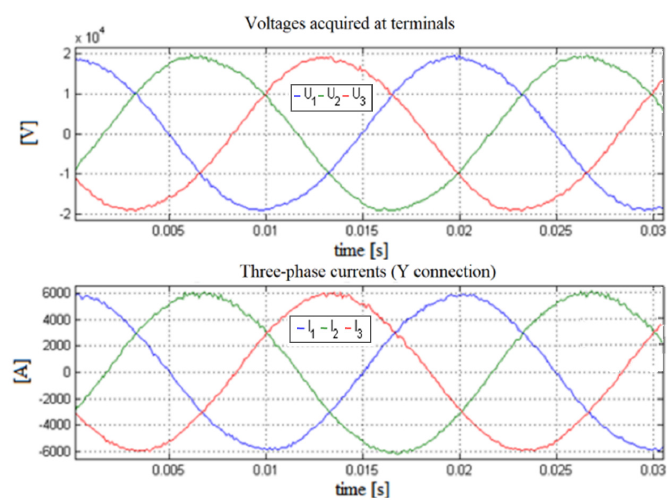
Figure 23. Three-phase voltages and currents acquired from the main generator termi- nals for an active power of 171 MW delivered to the national power system.